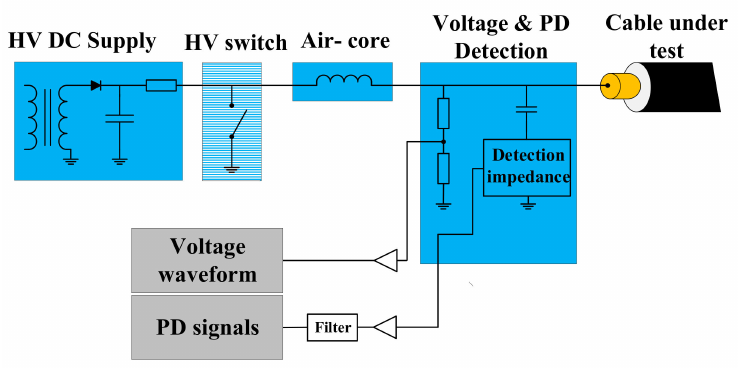
Figure 6. Schematic diagram of Oscillating Waveform Test System (OWTS) diagnostic